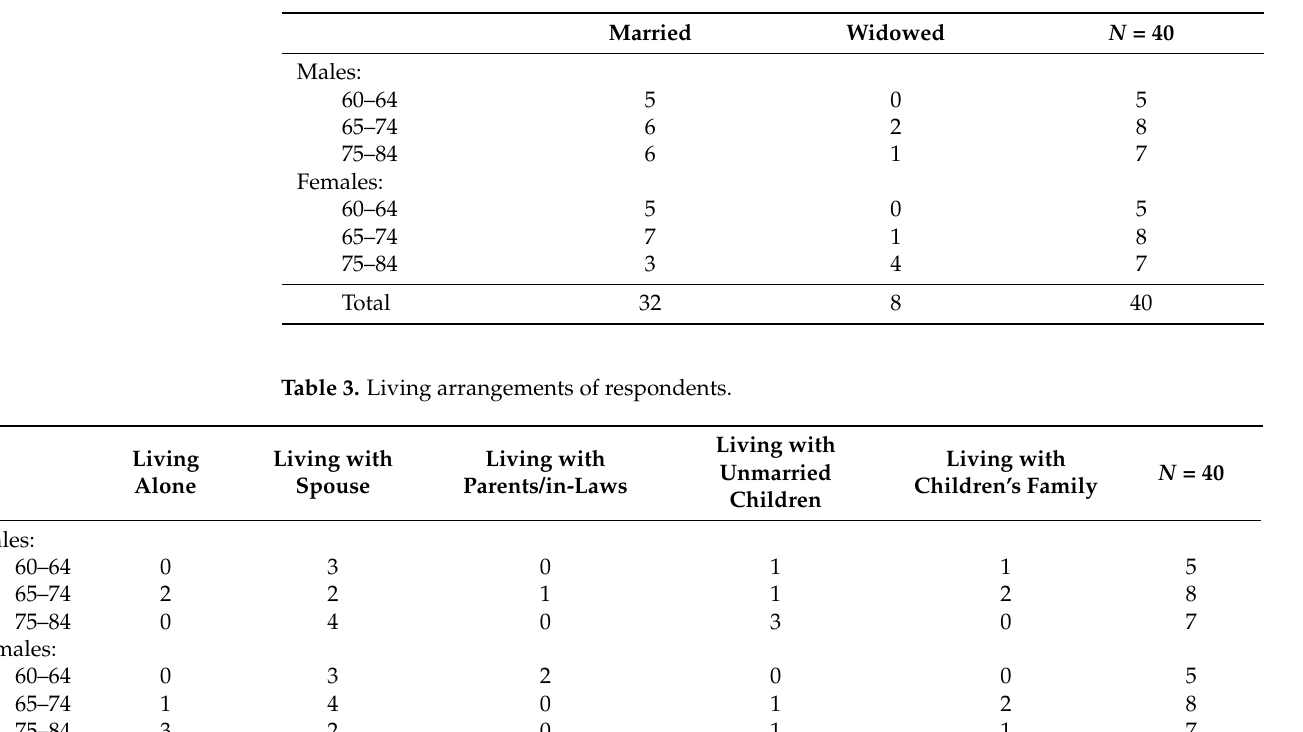
Table 2. Marital status of respondents.